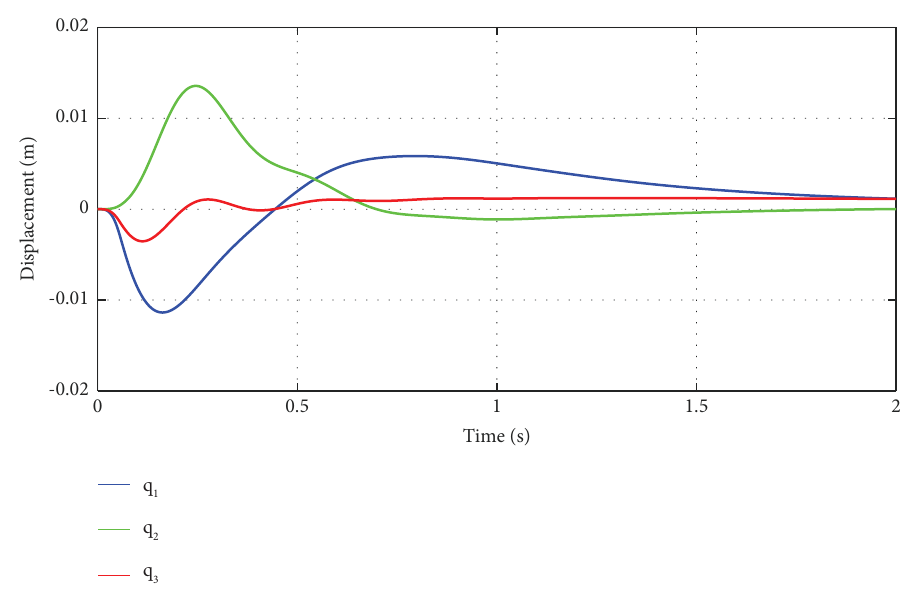
� 45 ° : q -vertical displacement of 0 1